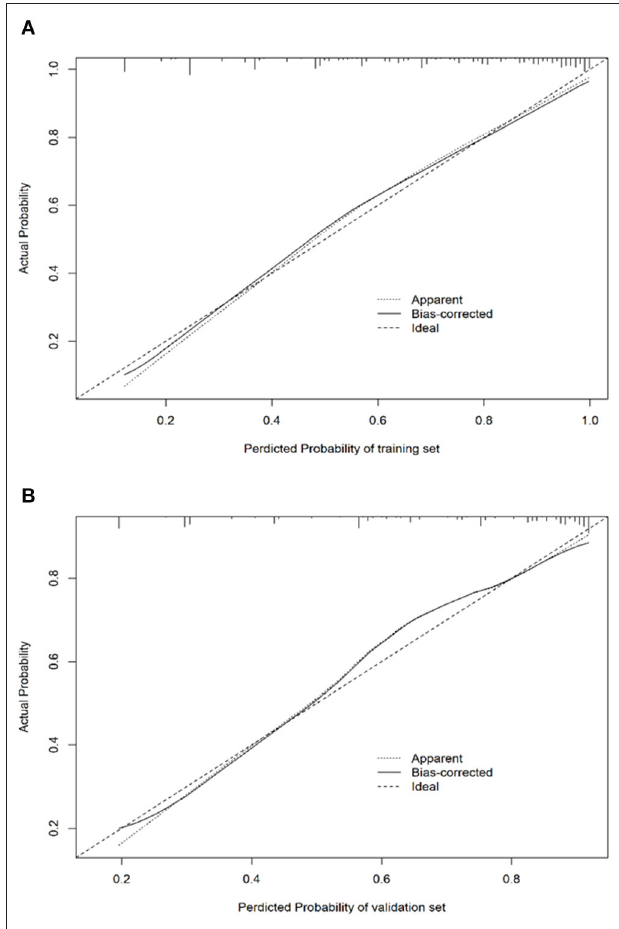
FIGURE 4 | Calibration plots for prediction model in the training set (A) and validation set (B) .